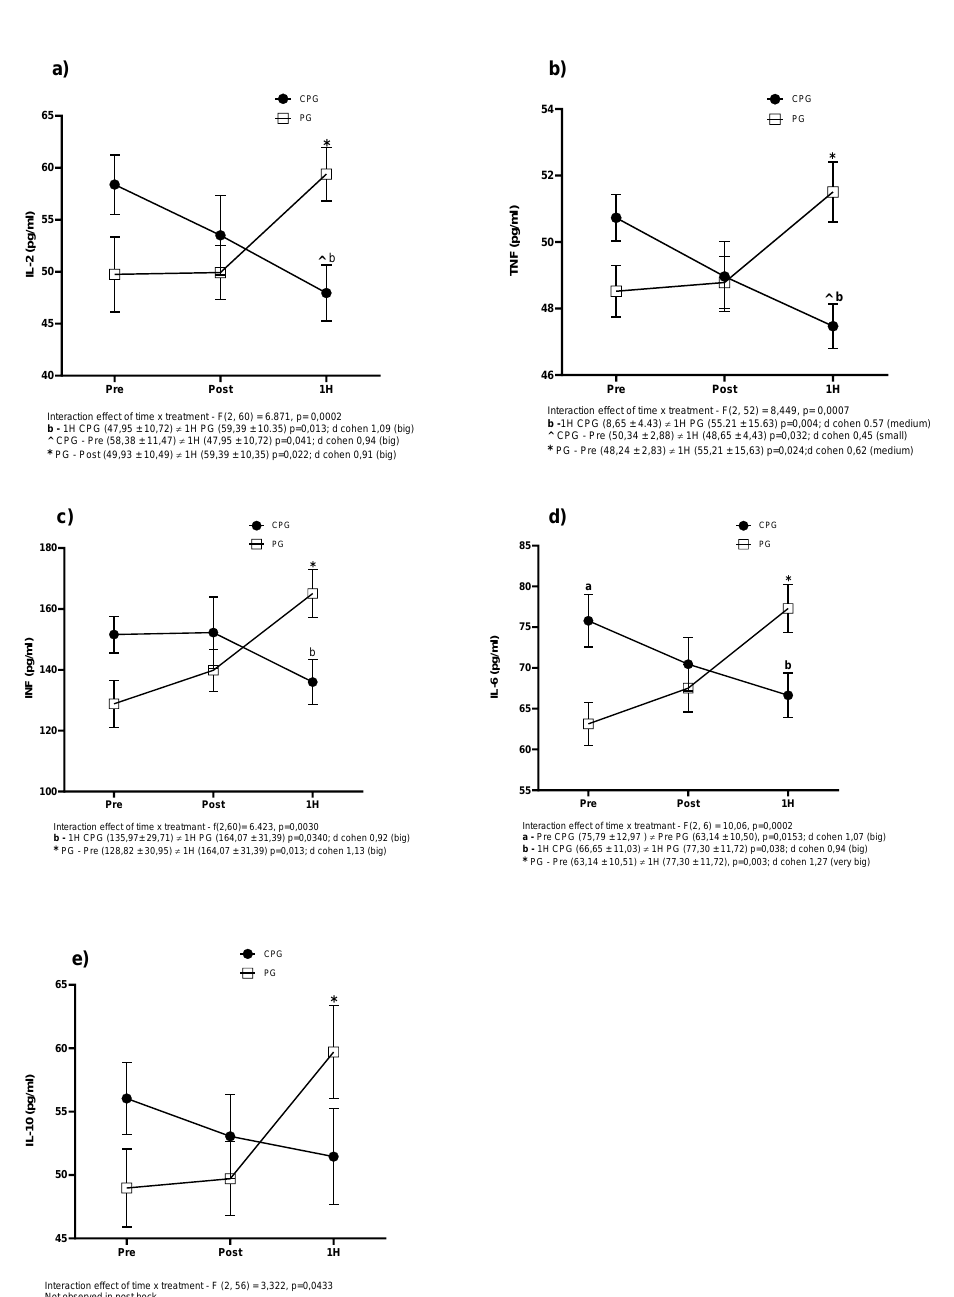
Figure 4. Chart represents the concentration (ng/mL) of creatine kinase (CK) following the experi- mental running protocol. Values represented by the mean ± SD, (#) interaction (effect of time).